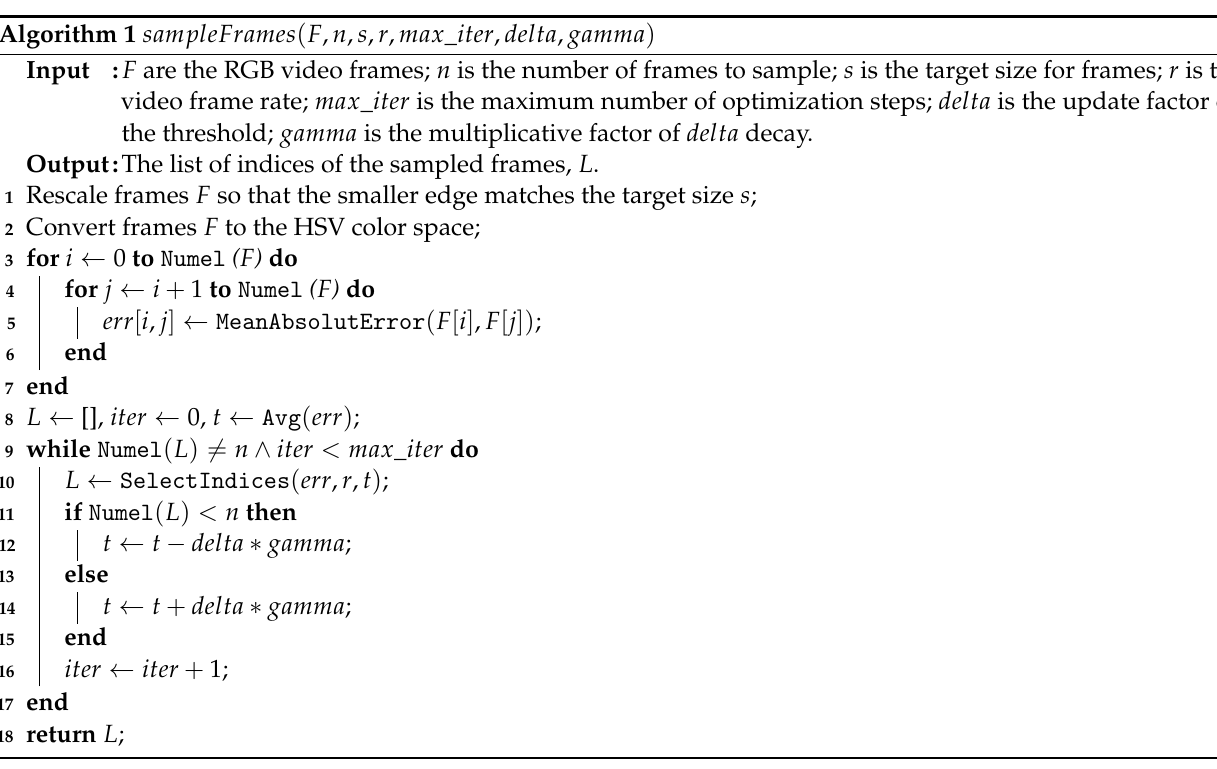
Algorithm 1 sampleFrames ( F , n , s , r , max _ iter , delta , gamma )